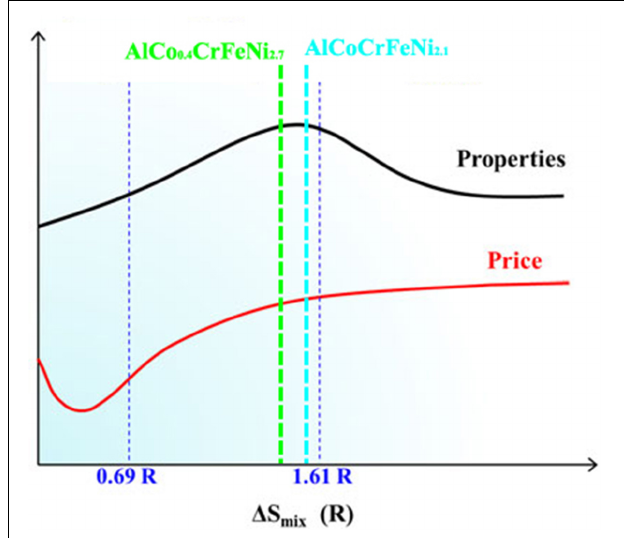
FIGURE 7 | Trend of the properties and price of the AlCo x CrFeNi 3 . 1 − x alloys and other alloys as a function of the entropy.